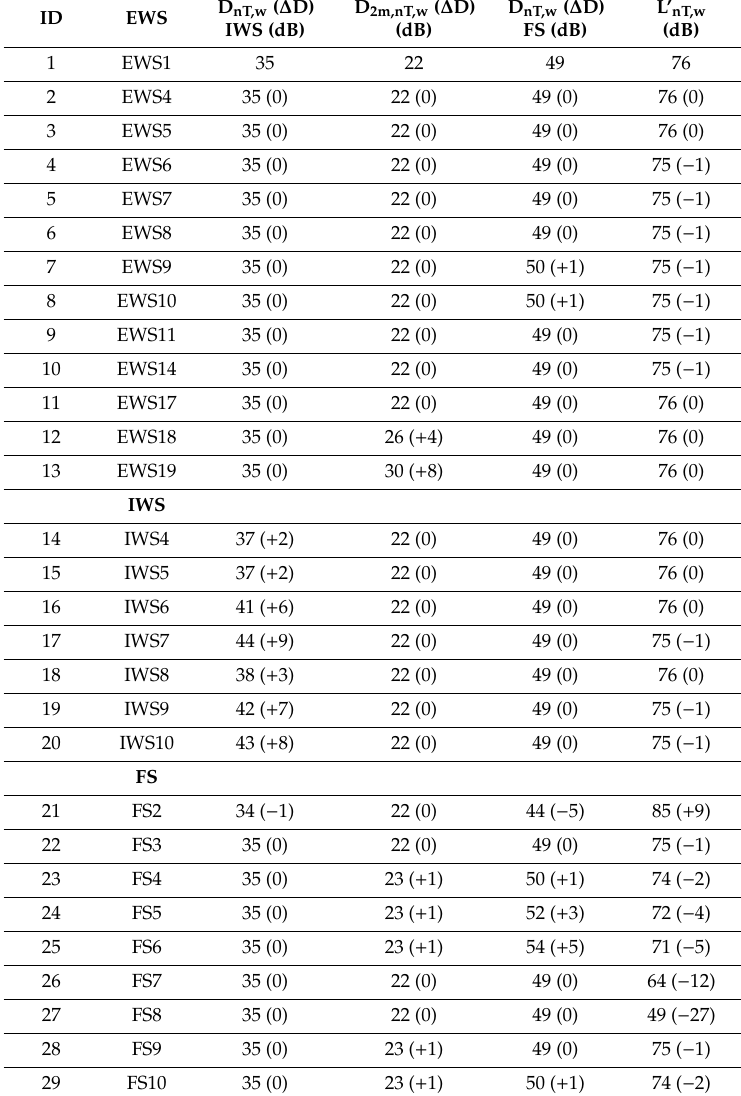
Table 20. Sound insulation results obtained in numerical simulation considering di ff erent external wall systems (EWS), internal wall Systems (IWS), and floor systems